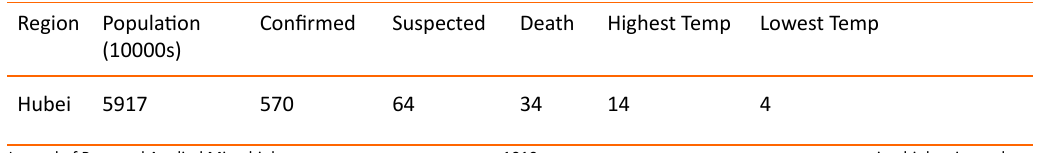
Table 2. A sample of records in the COVID-19 Data Set Region